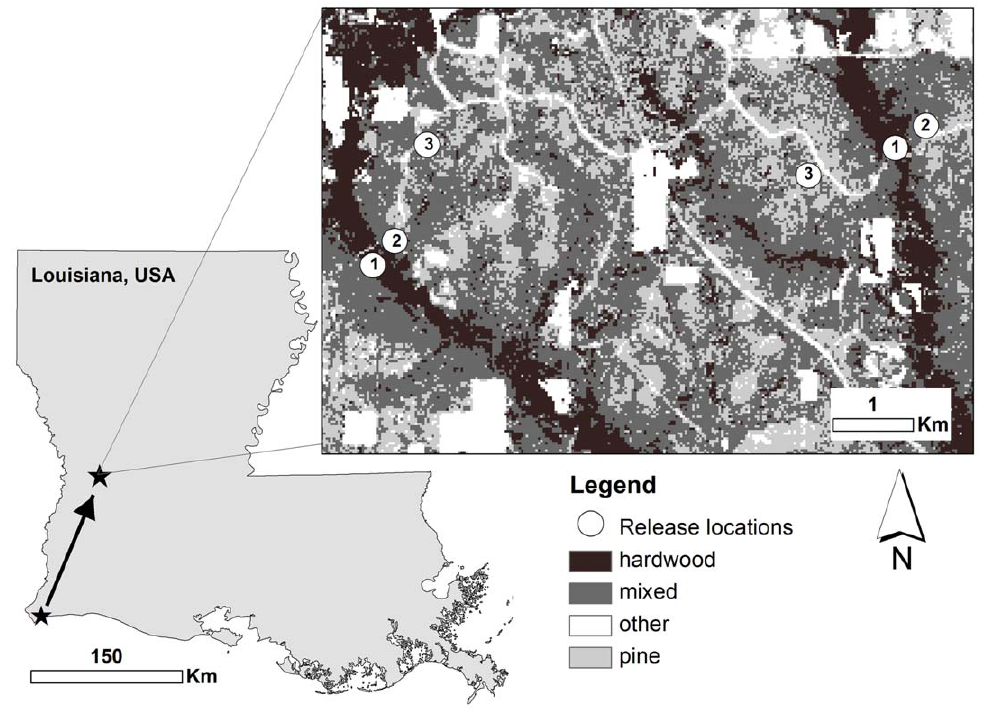
Figure 1. Map of study area. Migratory red-eyed vireos were captured at Johnson’s Bayou during spring migration and translocated to Kisatchie National Forest Louisiana, USA. Inset map is of Kisatchie National Forest showing release locations in two replicates of three forested habitat types, hardwood (1) mixed (2), and pine (3).